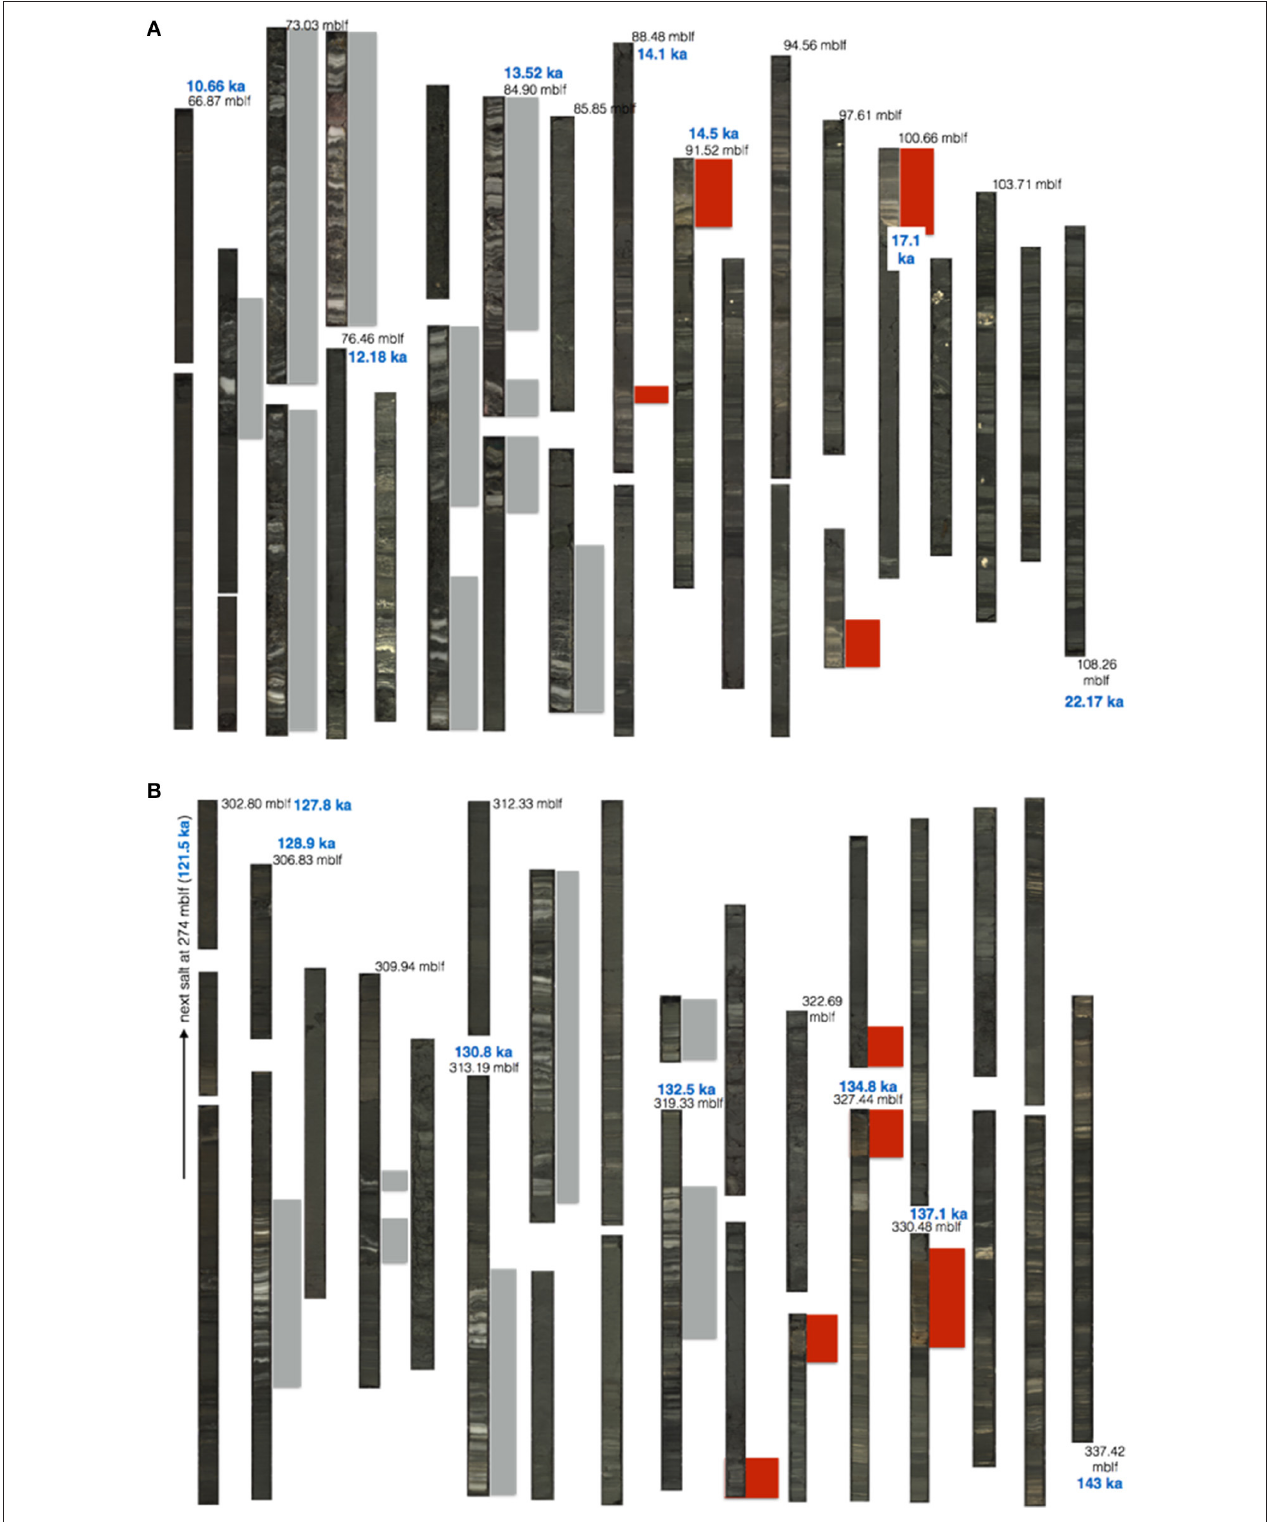
FIGURE 4 | DSDDP core photos of (A) Termination-I, and (B) Termination-II. Depth in meters below lake floor (mblf), and ages (ka) are marked in black and blue, respectively (ages after Torfstein et al., 2015). Red and gray rectangles highlight the location of gypsum and halite intervals, respectively.